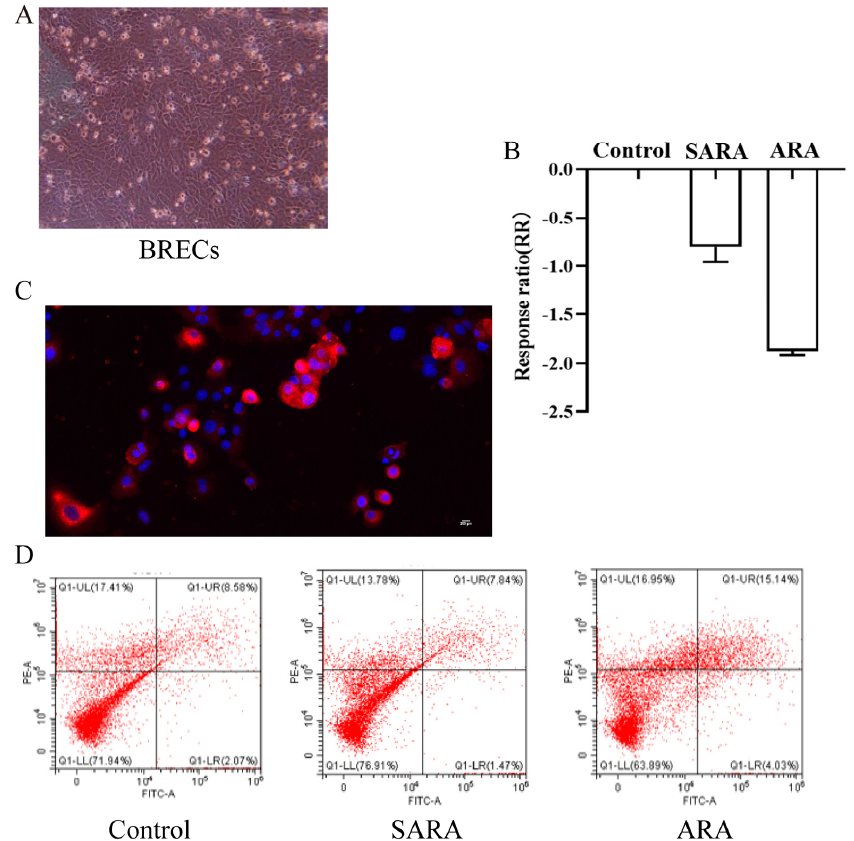
Figure 1. Effects of the morphology and pH of BRECs on their viability and apoptosis. ( A ). Mor- phology of BRECs (100 × ) ( B ). Effect of pH treatments on the viability of rumen epithelial cells. The abscissa represents the processing group, ordinate RR = ln (ODtreated/ODuntreated), optical density (OD); ODtreated indicates the OD values of treated cells, ODuntreated indicates the OD values of cells without treatment, RR > 0 indicates an increase in the relative viability of cells treated with butyrate compared with untreated cells, and RR < 0 indicates a decrease in the relative viability of cells treated with butyrate compared with untreated cells. ( C ). Immunofluorescence staining of keratin 18 in BRECs. Red indicates keratin 18 and blue indicates the nucleus. ( D ). Apoptotic rates of BRECs detected by flow cytometry. PE = phycoerythrin; FITC = fluorescein